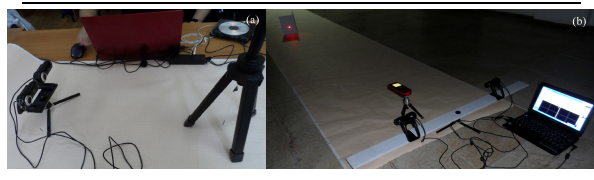
Figure 6: The experiment on the evaluation of absolute inaccuracy of measuring distance to the (a) nearly-located and (b) far-located object (with b = 9.7 cm and b = 51.15 cm respectively).